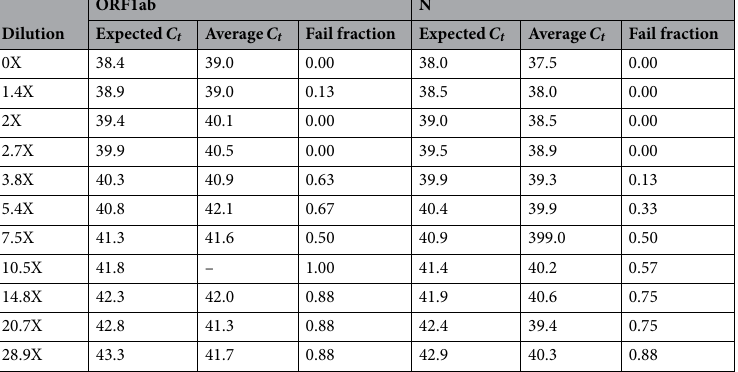
Table 2. Expected Ct, average C t , and the fraction of wells with no reading for markers N and ORF1ab for successive dilutions of the same